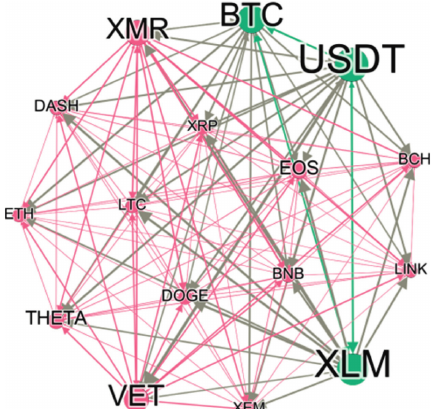
Figure 47: Risk spillover under